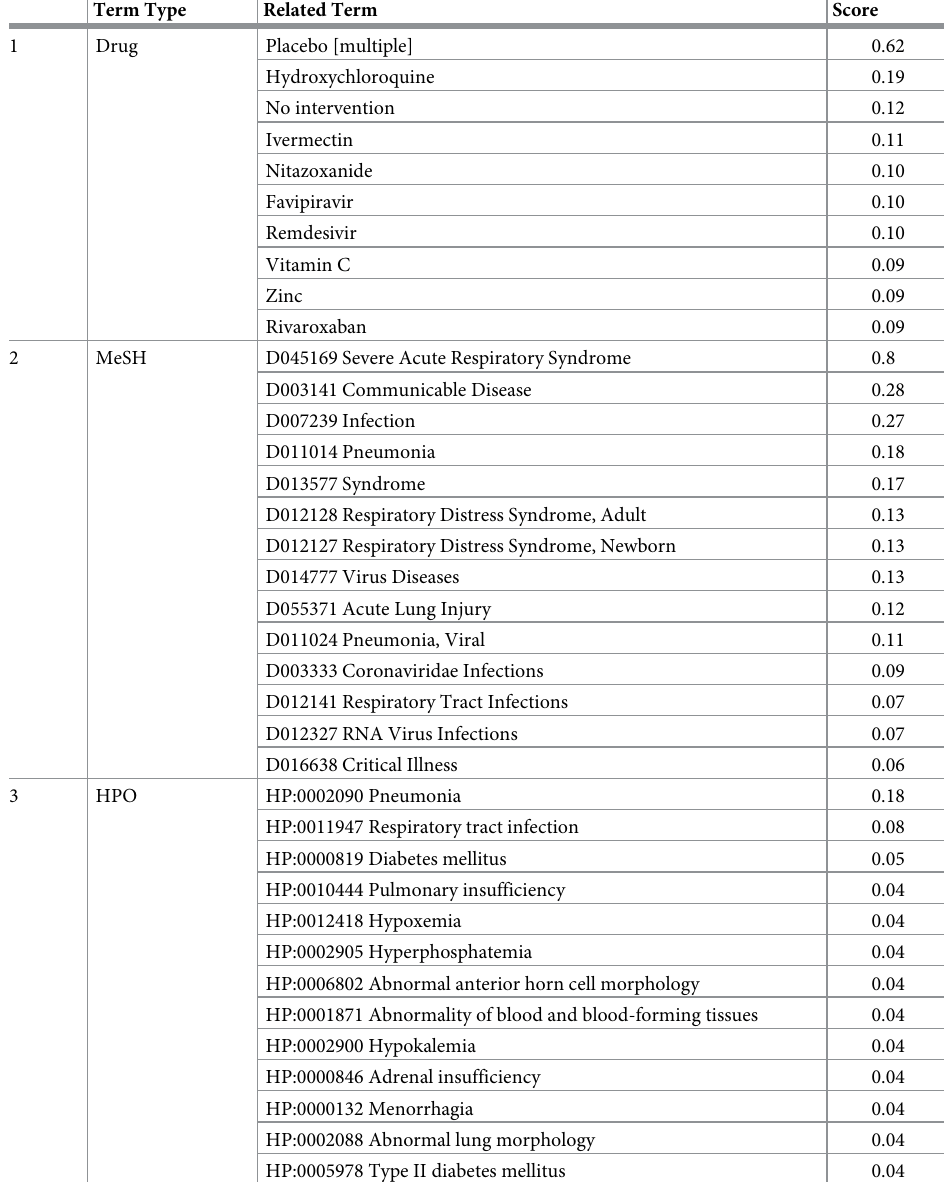
Table 1. Related drugs, MeSH, and HPO terms using co-occurrences with D018352: Coronavirus